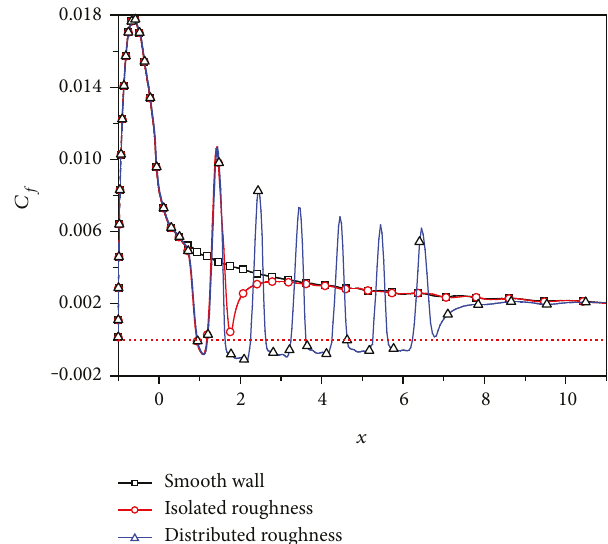
Figure 5: The distribution of friction coe ffi cient of the wall along the fl ow distribution.